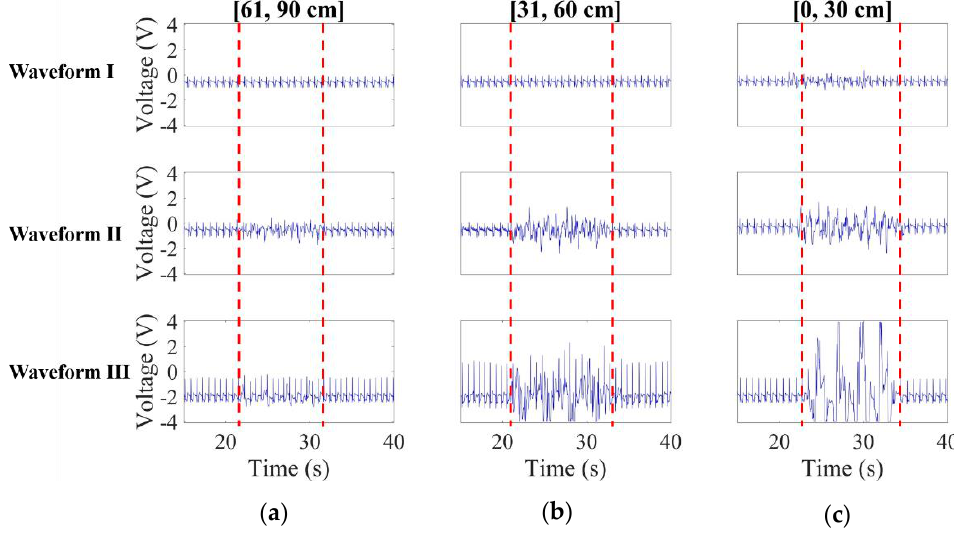
Figure 15. CECG waveform comparison when the human noise source approached the subject at 30 cm/s over intervals ( a ) [61, 90 cm], ( b ) [31, 60 cm] and ( c ) [0, 30 cm].